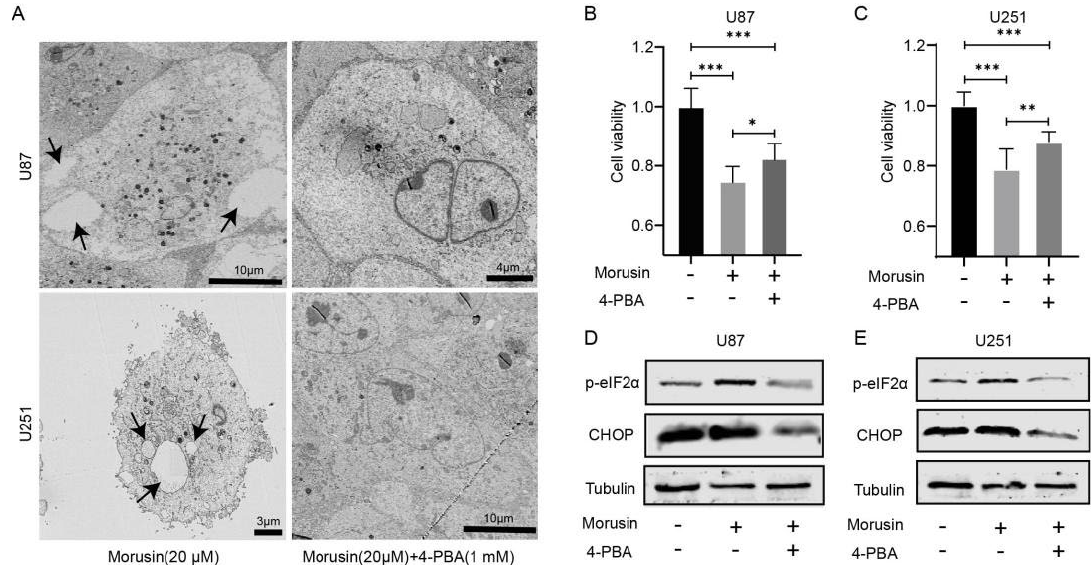
Figure 3. 4-PBA rescued the cytotoxicity of morusin in GBM cells. ( A ) Cytoplasmic vacuolation in U87 and U251 cells after morusin (20 µM) and 4-BPA (1 mM) treatment for 12 h. Cells were visualized via transmission electron microscopy. ( B , C ) Cell viabilities of U87 and U251 cells after exposure to morusin (20 µM) with or without 4-BPA (1 mM) for 24 h. ( D , E ) Protein changes of p- eIF2α and CHOP in in U87 (D) and U251 (E) were determined by Western blot. Tubulin was used as a loading control. n = 3, * p < 0.05, ** p < 0.01, *** p < 0.0001 compared to indicated comparator.